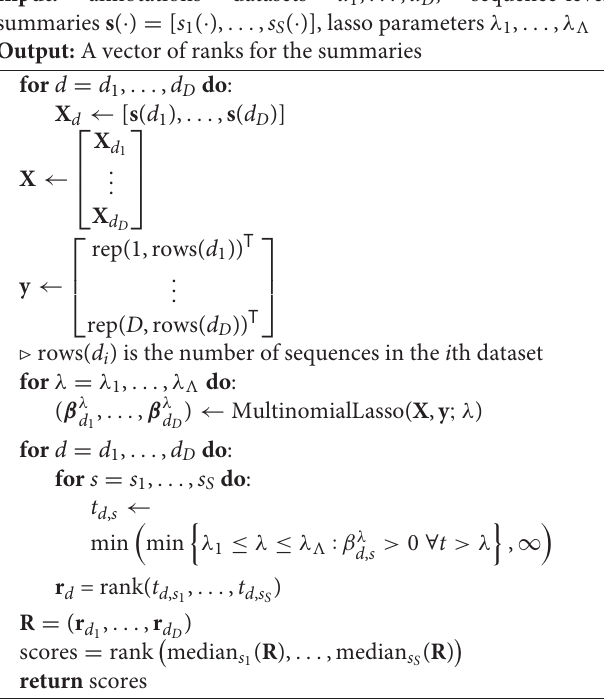
Algorithm 3: Rank summary statistics by